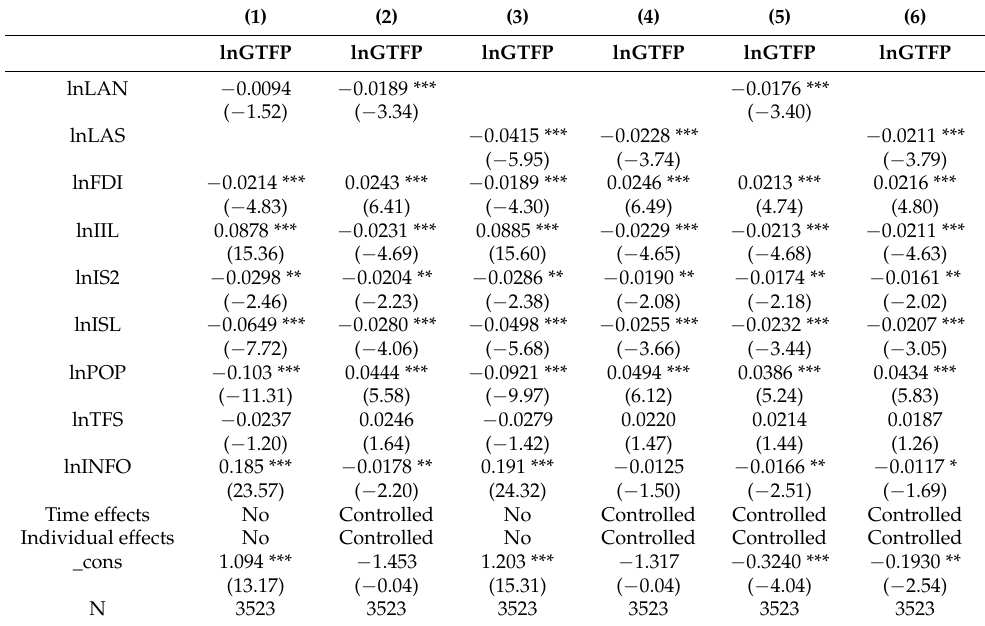
Table 12. The comparison of the Panel Tobit model and Panel OLS